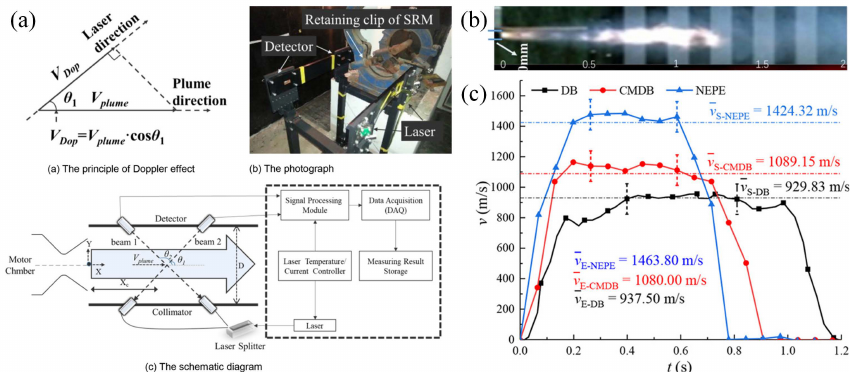
Figure 5. ( a ) Schematic and setup of the tunable diode laser absorption spectroscopy (TDLAS). ( b ) Recorded plume snapshot. ( c ) The measured velocity by the TDLSA for different propellants [72].